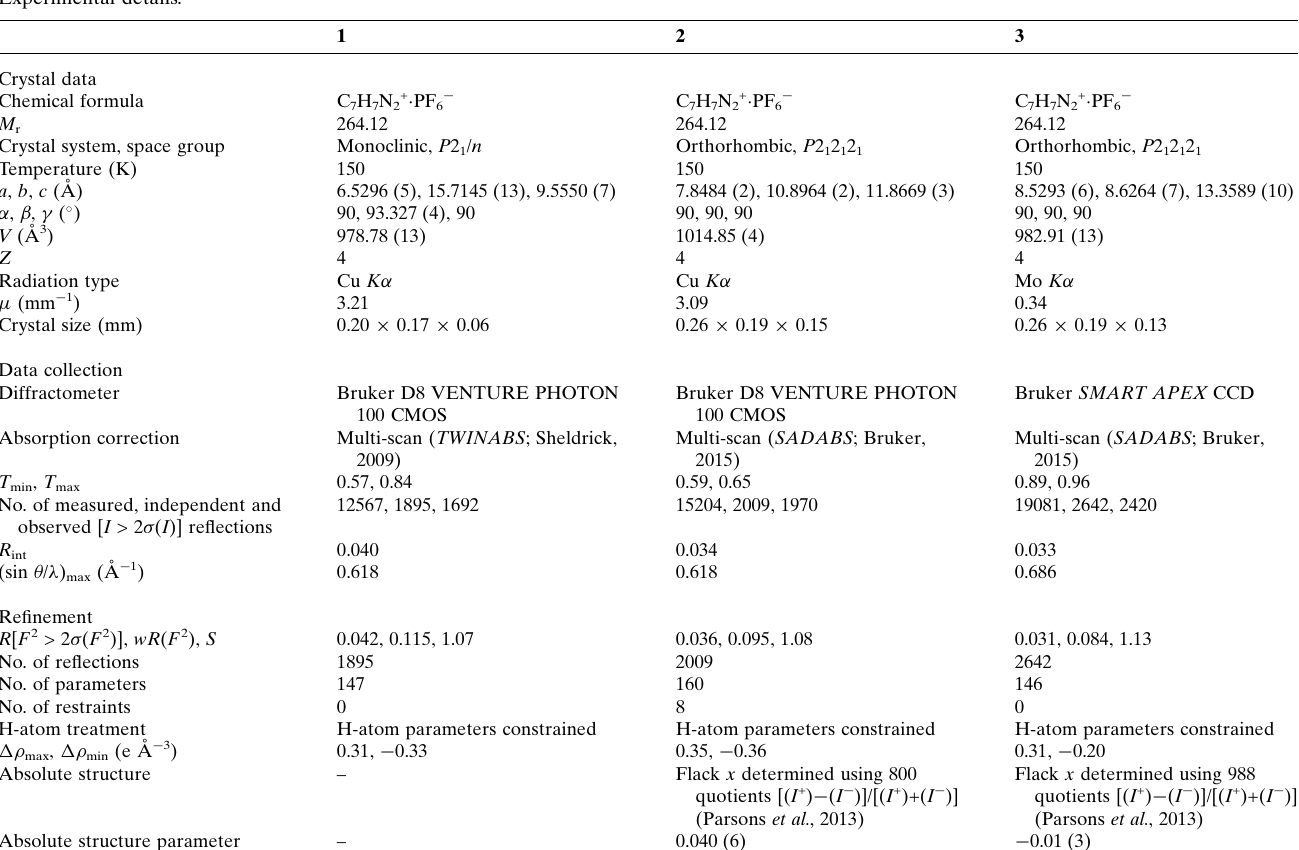
Table 5 Experimental details.